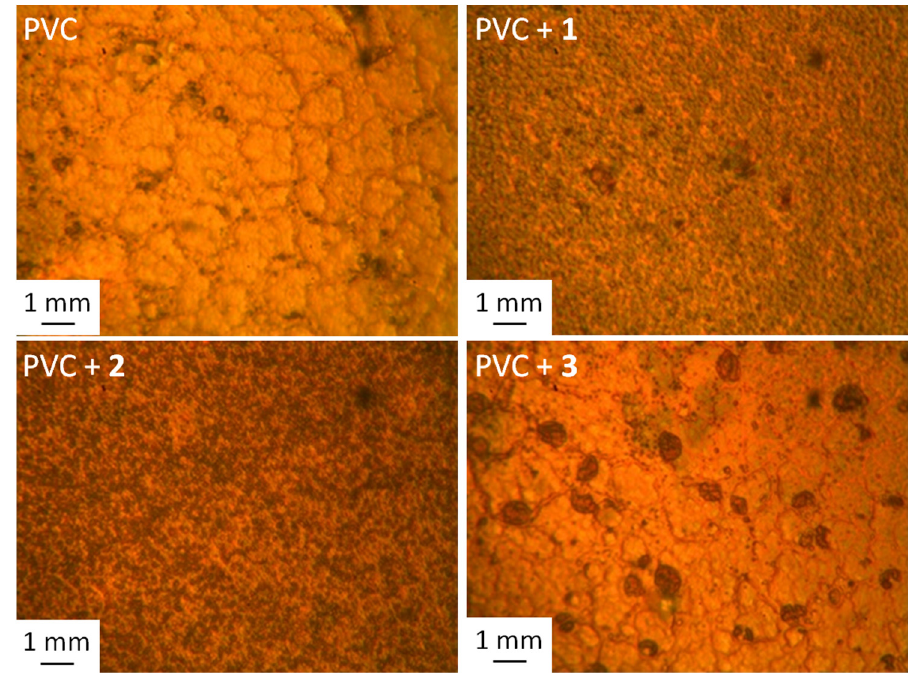
Figure 6. Microscope images of PVC films after irradiation at 300 h.